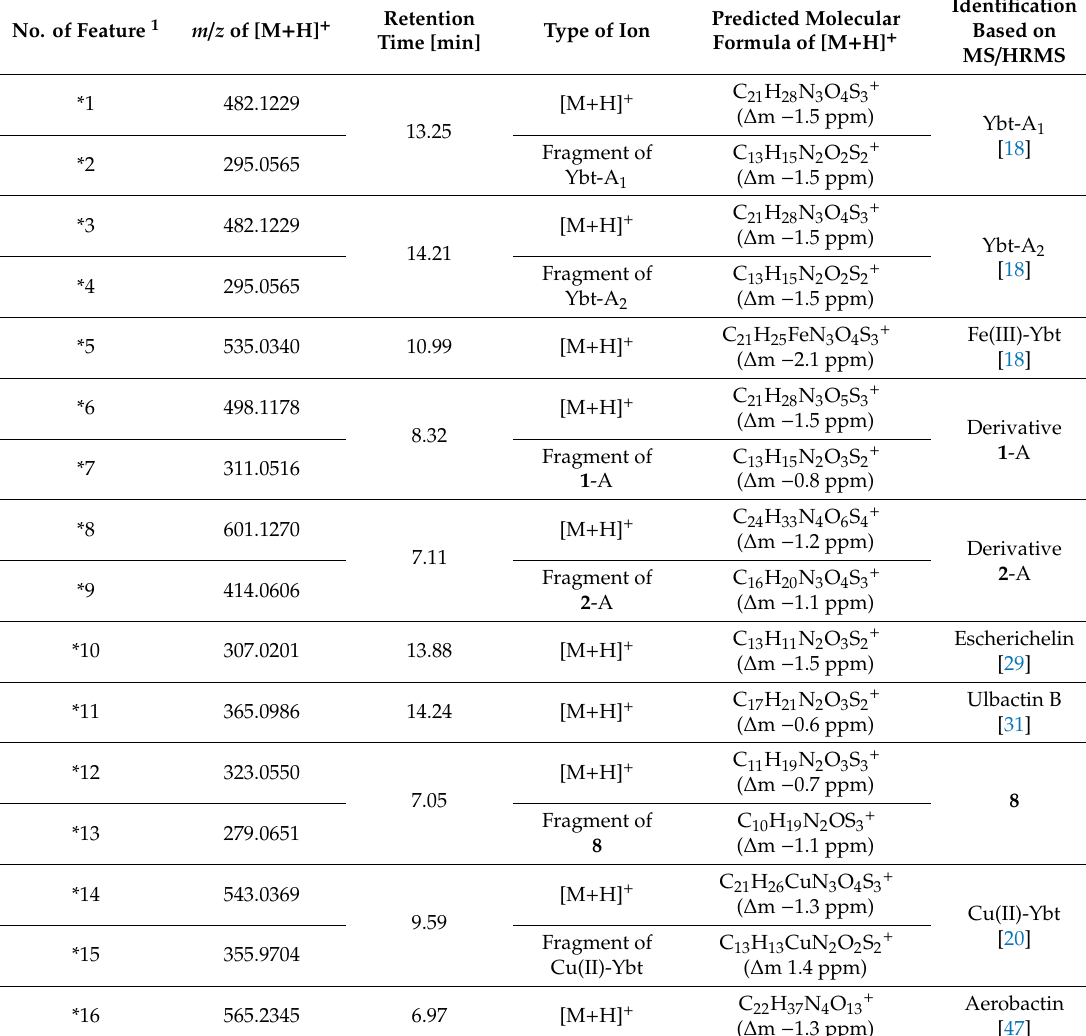
Table 1. List of the features that represent the [M + H] + ions for the most significant metabolites likely to be responsible for the significant di ff erences of the metabolome of EcN compared to the metabolome of E. coli strains 83972 and CFT073 and the blank sample. Newly detected substances are labeled as bold numbers, isomeric forms showing di ff erences in the retention time and fragmentation pattern are di ff erentiated by capital letters (e.g., 1 -A and 1 -B), isomers di ff ering in retention time but not in fragmentation pattern are di ff erentiated with di ff erent subscript numbering (e.g., Ybt-A 1 and Ybt-A 2